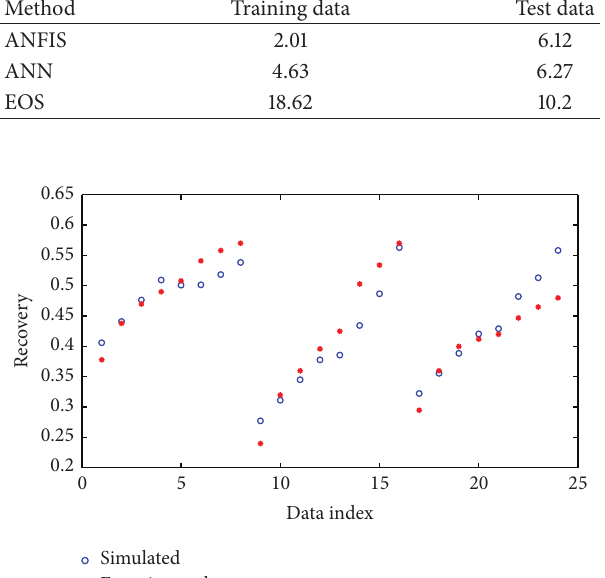
Figure 6: Performance of ANFIS for test